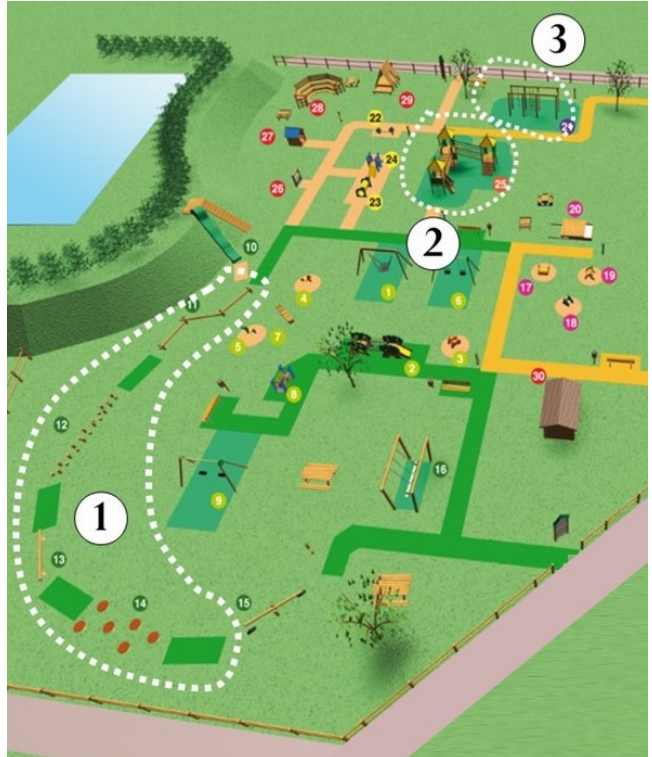
Figure 2. Dotted lines limit the areas where structured activities were run. 1: Balance area; 2: mobility area; 3: manual dexterity area. Active play (unstructured activities) could be performed everywhere else in the park according to children’s choice.